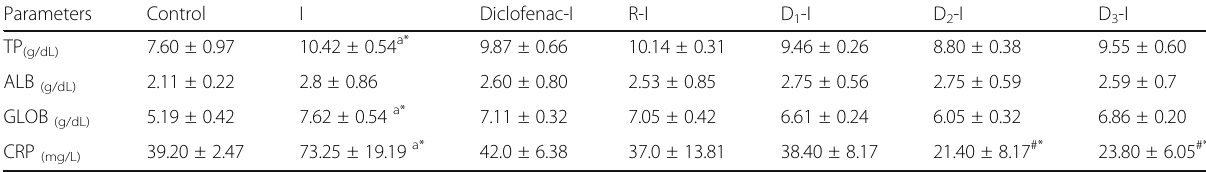
Table 5 Plasma proteins and C reactive protein (CRP) of control and experimental animals. Values are expressed as mean ± SEM